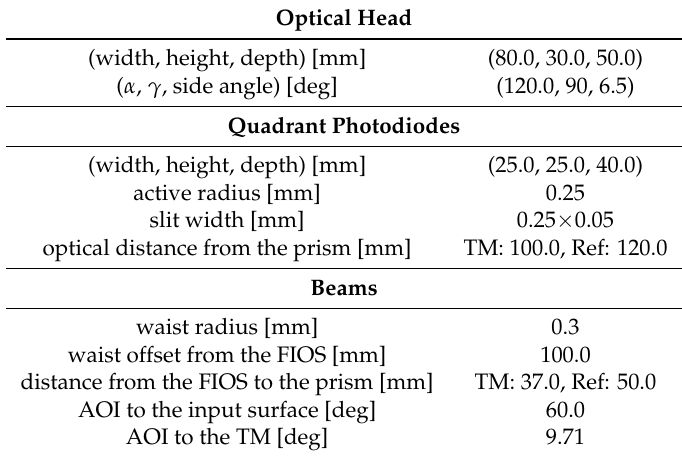
Table A1. Parameters of the whole setup. AOI is angle of